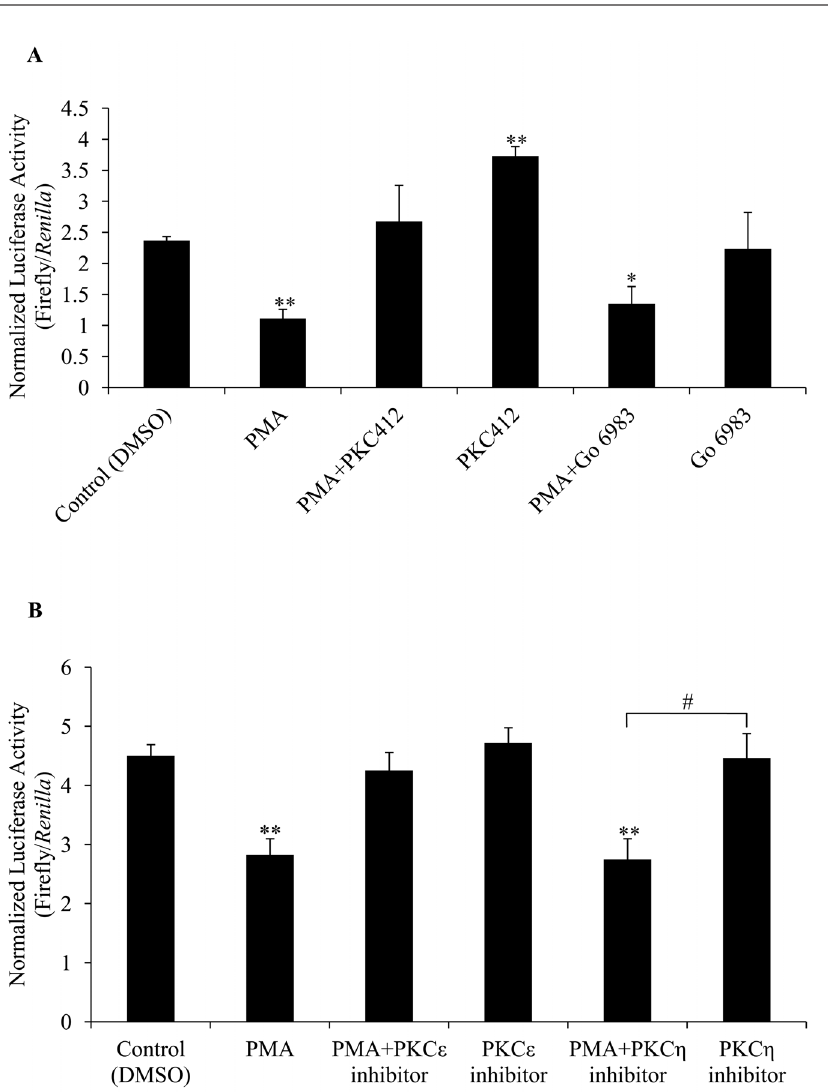
Figure 7. Effect of PKC inhibitors (PKC412 and Go 6983) on the PMA-mediated repression of ck b promoter activity. (A) MCF-7 cells were individually or co-treated with 20 ng/mL PMA, 1 mM PKC412 and 0.1 mM Go 6983 for 6 hr. Each bar represents the mean ¡ SEM of triplicate samples from three independent experiments. (* p , 0.05 and ** p , 0.01 vs. DMSO control). (B) MCF-7 cells were individually or co-treated with 20 ng/mL PMA, 10 m M PKC e inhibitor peptide and 10 m M PKC g pseudo-substrate inhibitor for 6 hr. Each bar represents the mean ¡ SEM of triplicate samples from three independent experiments. (* p , 0.05 and ** p , 0.01 vs. DMSO control, # p , 0.05 between the two indicated